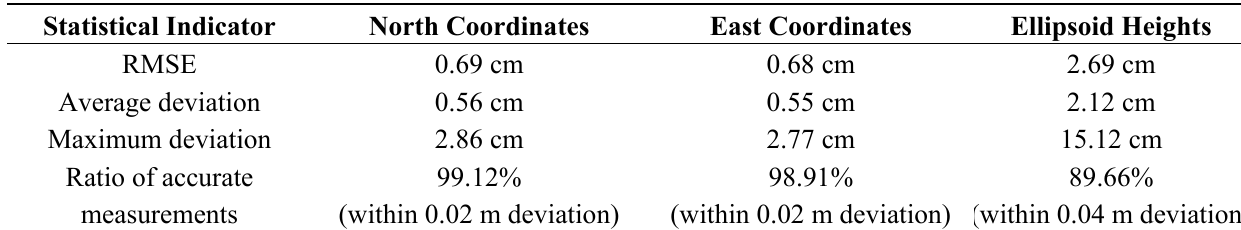
Table 3. Statistical indicators of the positioning accuracy of the NRTK application calculated from the test results at twelve fixed points displayed in Figure